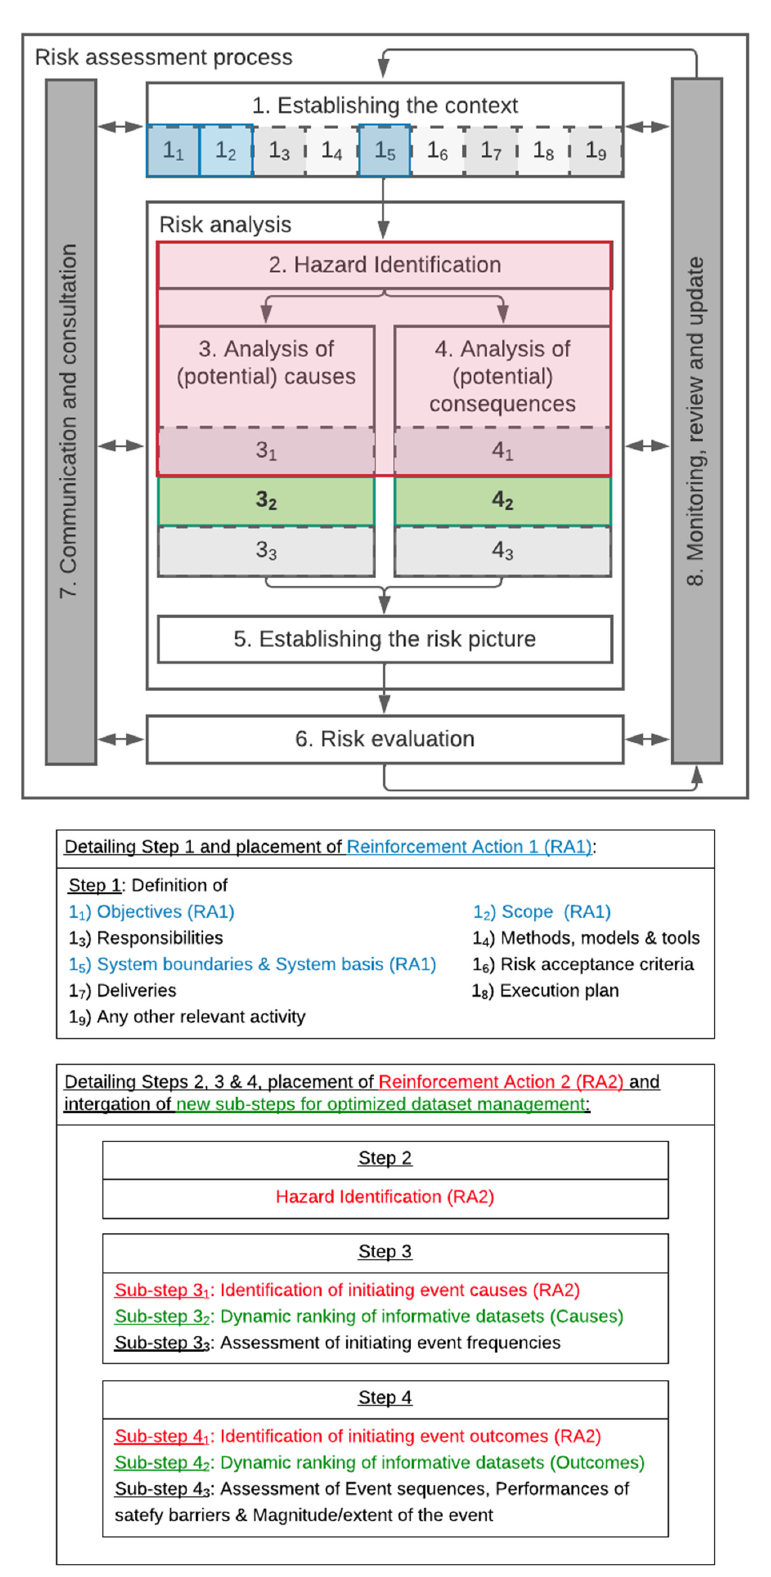
Figure 1. Augmented risk assessment framework Z-013 [51]. The steps highlighted in blue and red are the subject of augmentation (reinforcement actions 1 and 2), and the steps 3 2 and 4 2 in green are additional steps related to the optimization of data source/dataset management.